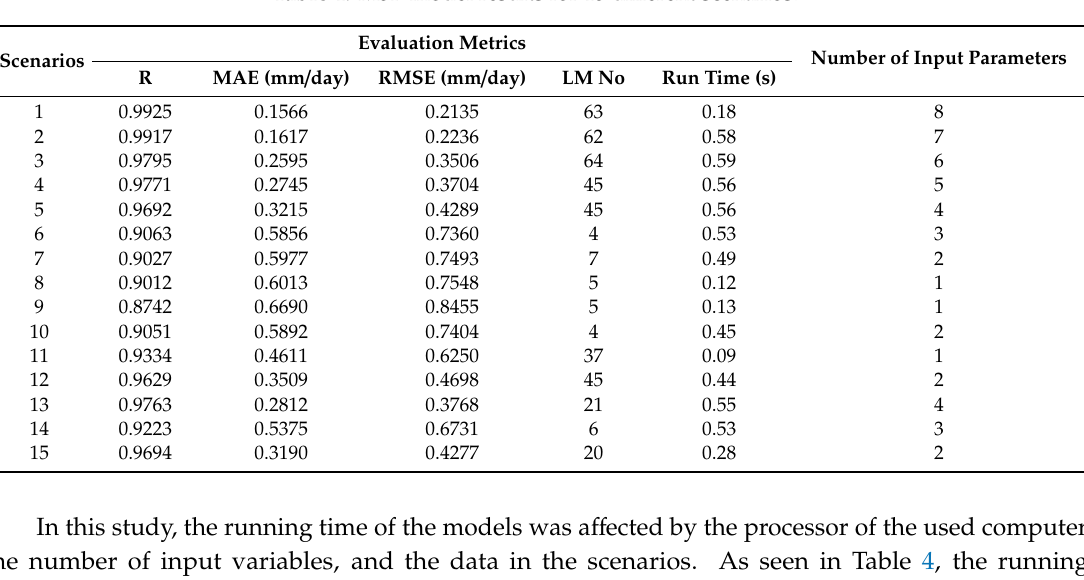
Table 4. M5P model results for 15 di ff erent scenarios.